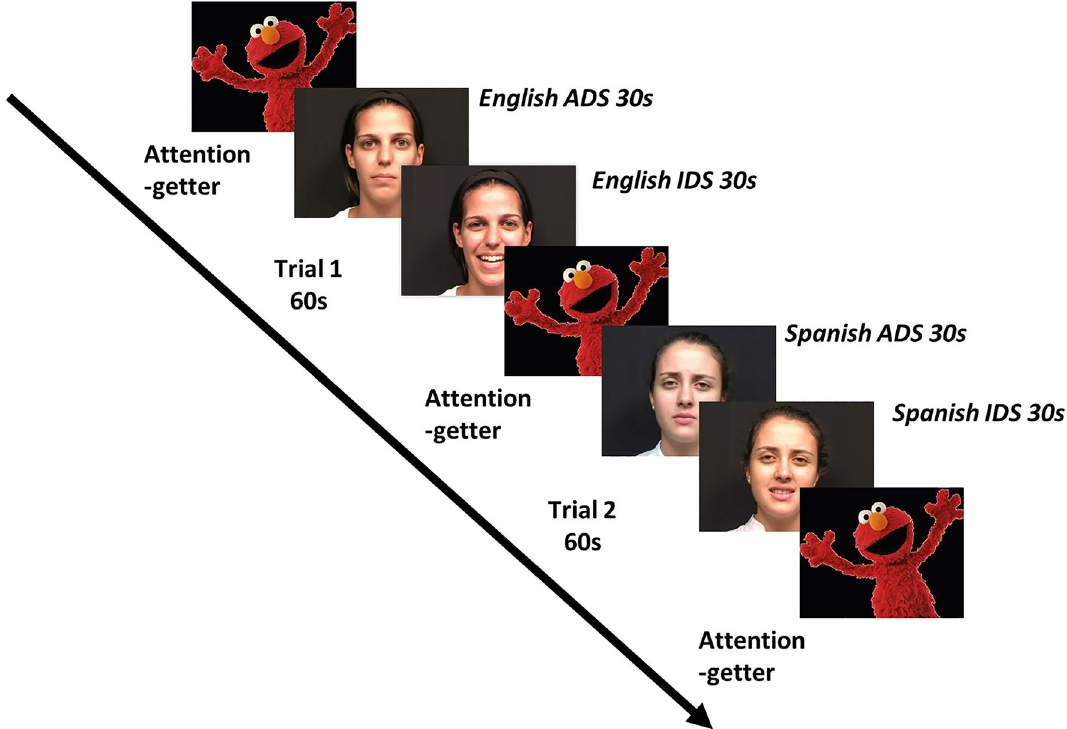
Figure 1. Example of first block of procedure used in Experiments 1 and 2. Stimuli credit to Lewkowicz and Hansen-Tift 46 .